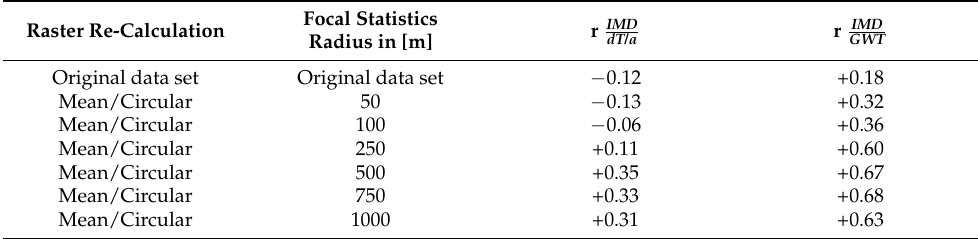
Table 4. Calculated Pearson correlation coefficients (r) of IMD against mean temperature shift and IMD against groundwater temperature, for different grid sets of IMD calculated via focal statistics.